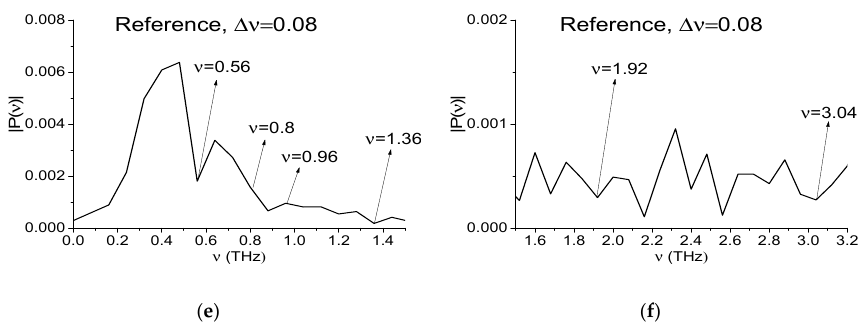
Figure 9. The Chocolate main pulse Fourier spectrum ( a , b ), Reference spectrum ( e , f ) and absorbance ( c , d ) in the frequency ranges ν = [0, 1.5] THz ( a , c , e ), [1.5, 3.2] THz ( b , d , f ) calculated with spectral resolution Δ ν = 0.08 THz.